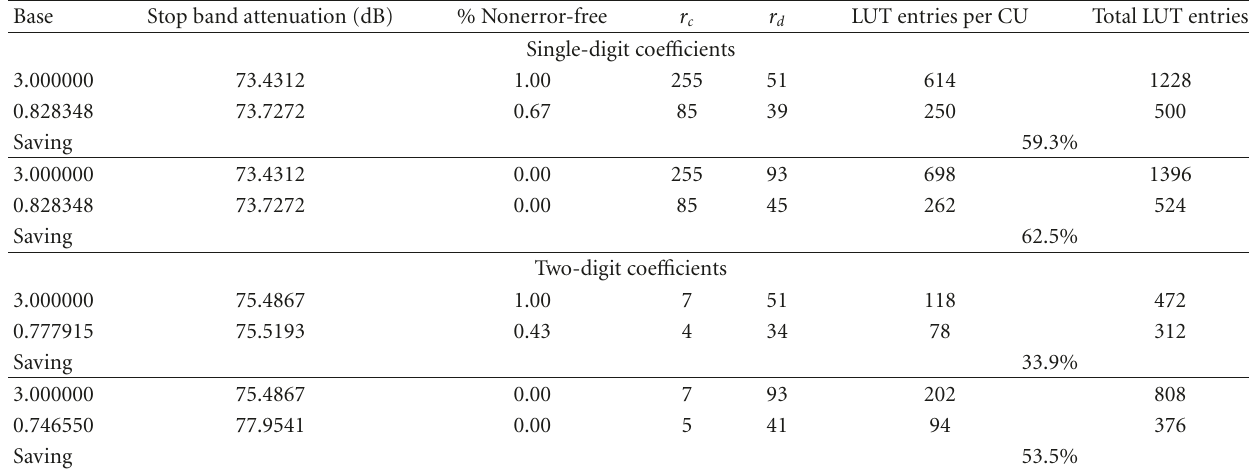
Table 7: Comparison of standard and optimal base for a minimum 73 dB system.